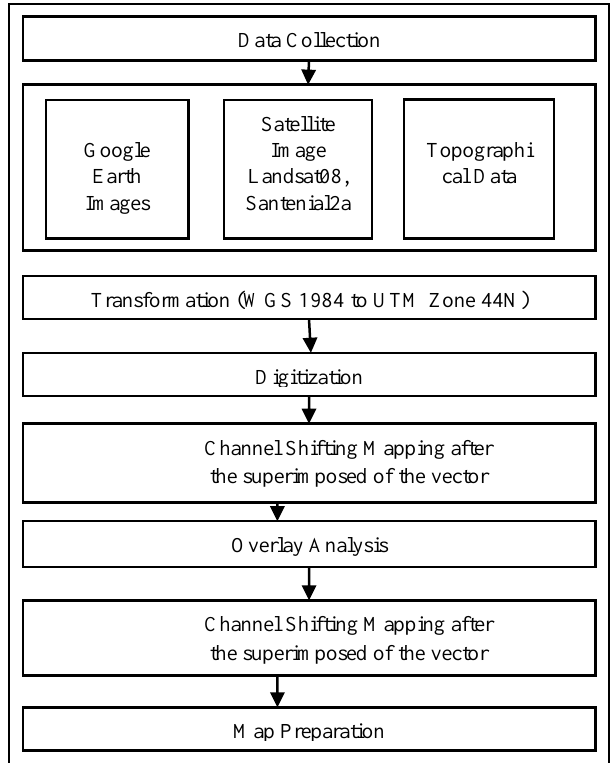
Fig 5: Methodology for the determination of lateral shift of river